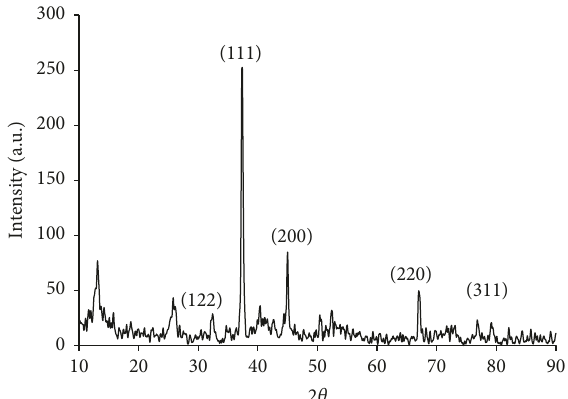
Figure 6: X-ray diffraction of obtained silver nanoparticles ( S (Ag + ) � 1.0mmol/L, τ � 10min, and ratio AgNO 3 :extract (mL) � 1:1).